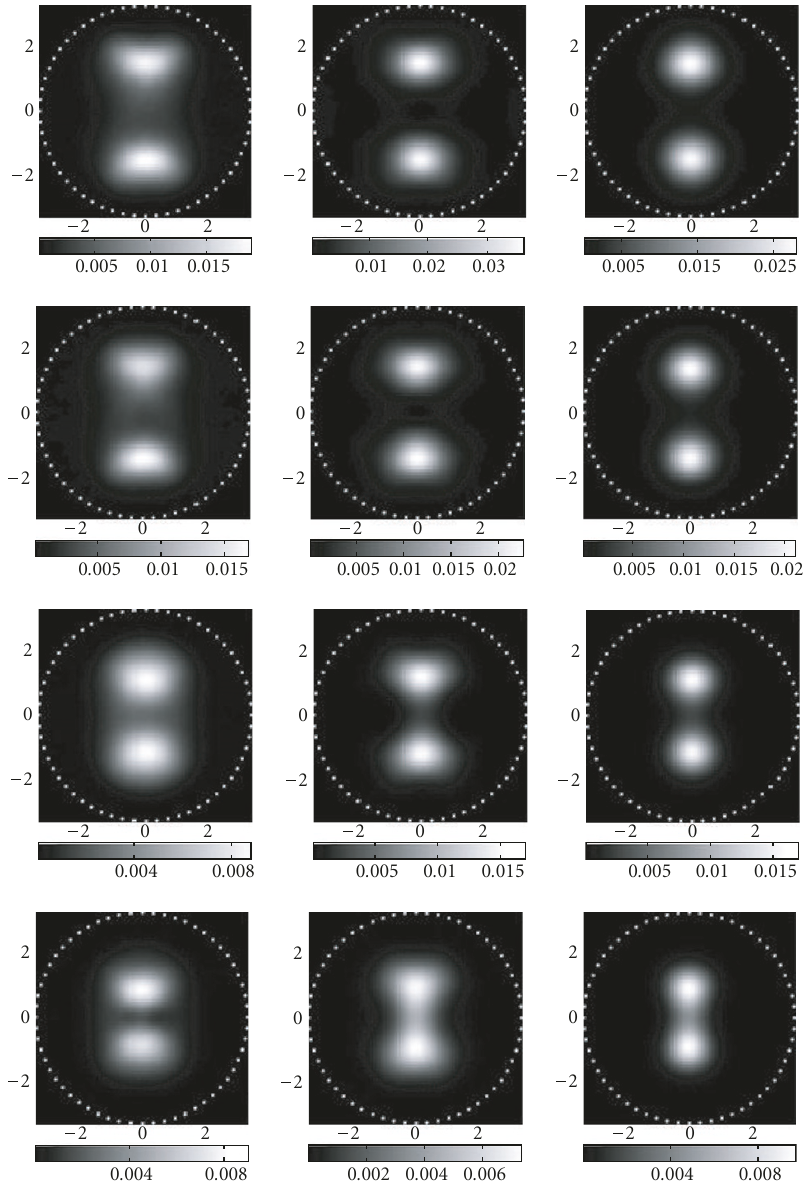
Figure 7: Comparison of the restoration results obtained with the use of preconditioned MRNSD (left and center) and unpreconditioned one (right): the second set of phantoms. Diameters of inhomogeneities from top to bottom are equal to 1 . 4, 1 . 2, 1 . 0, and 0 . 8 cm.